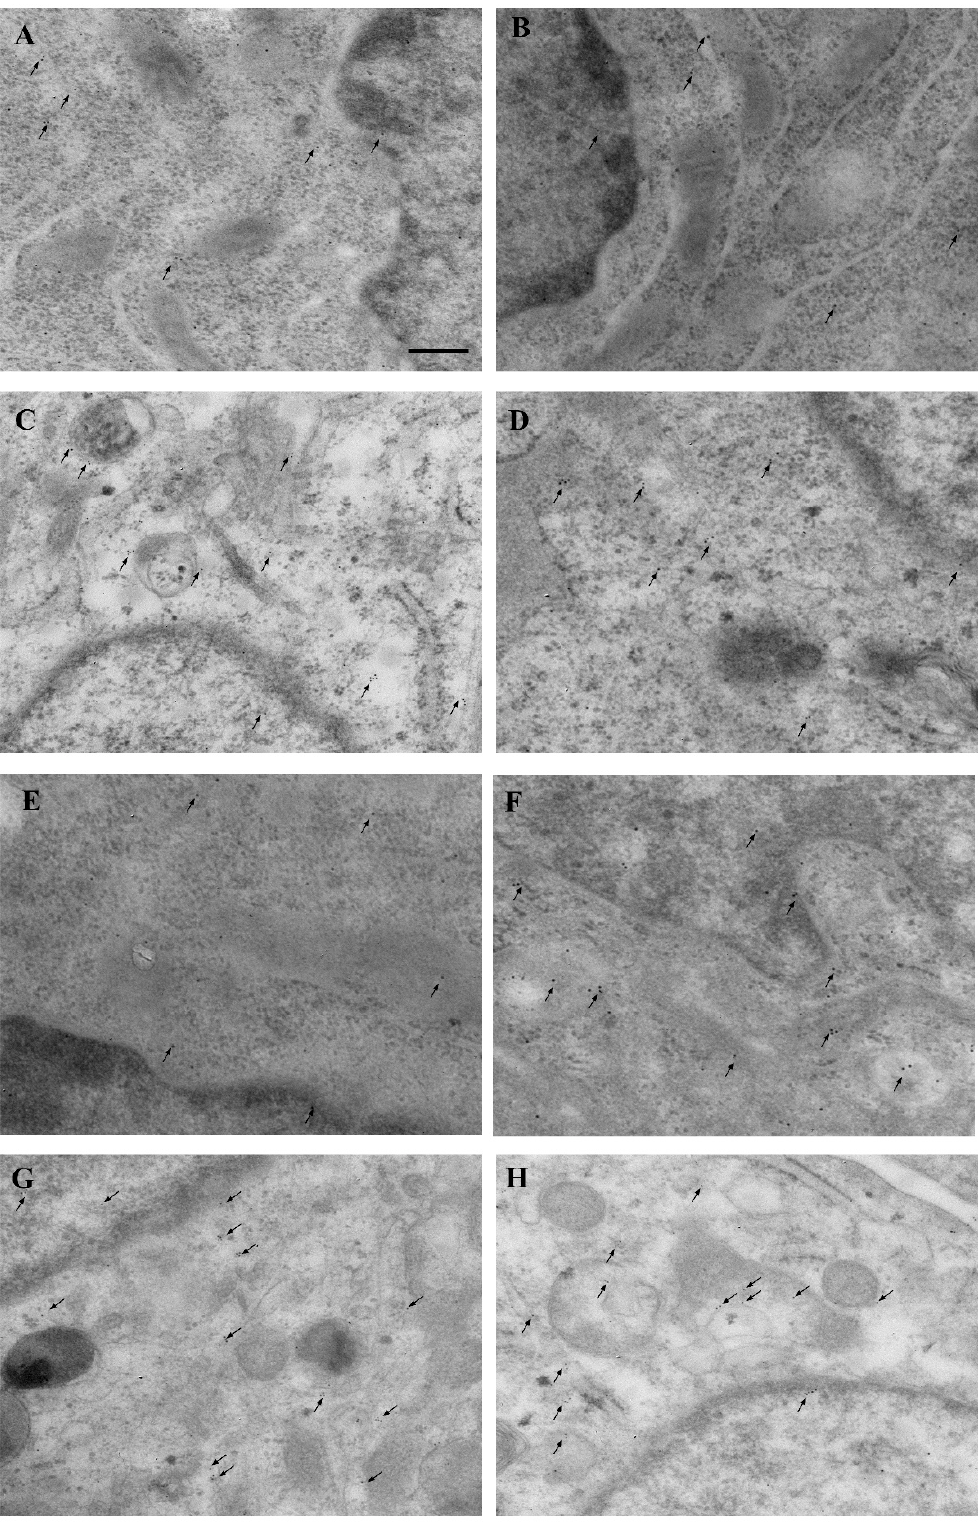
Figure 16. α -Syn immuno-electron microscopy in co-cultures of astrocytes and A172 cells in base- line and following rapamycin administration. Representative micrographs show α -syn immuno- gold particles (arrows) within cytoplasm and nucleus of astrocytes co-cultured with astrocytes ( A ); astrocytes co-cultured with A172 cells ( B ); A172 cells co-cultured with A172 cells ( C ), A172 cells co-cultured with astrocytes ( D ), astrocytes co-cultured with astrocytes treated with rapamycin ( E ), astrocytes co-cultured with A172 cells treated with rapamycin ( F ), A172 cells co-cultured with